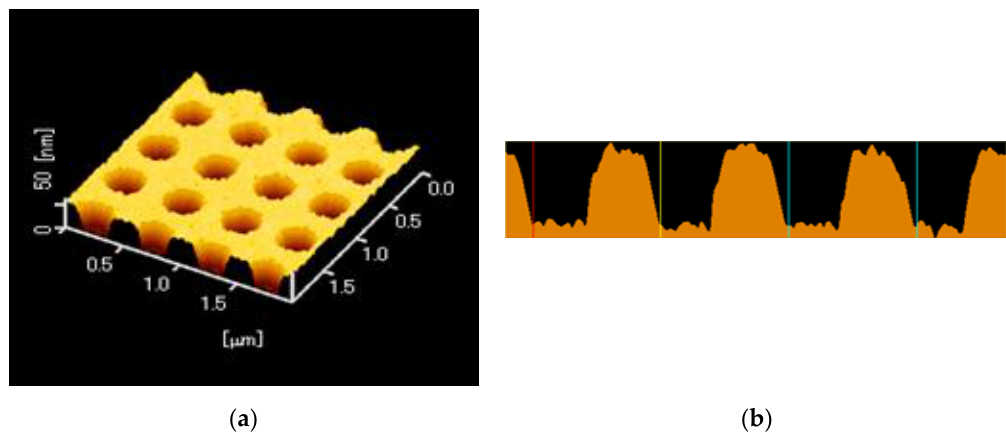
Figure 3. ( a ) An atomic force microscopy (AFM) image of a plasmonic chip with a hole-arrayed structure. ( b ) A cross-sectional view of the periodic